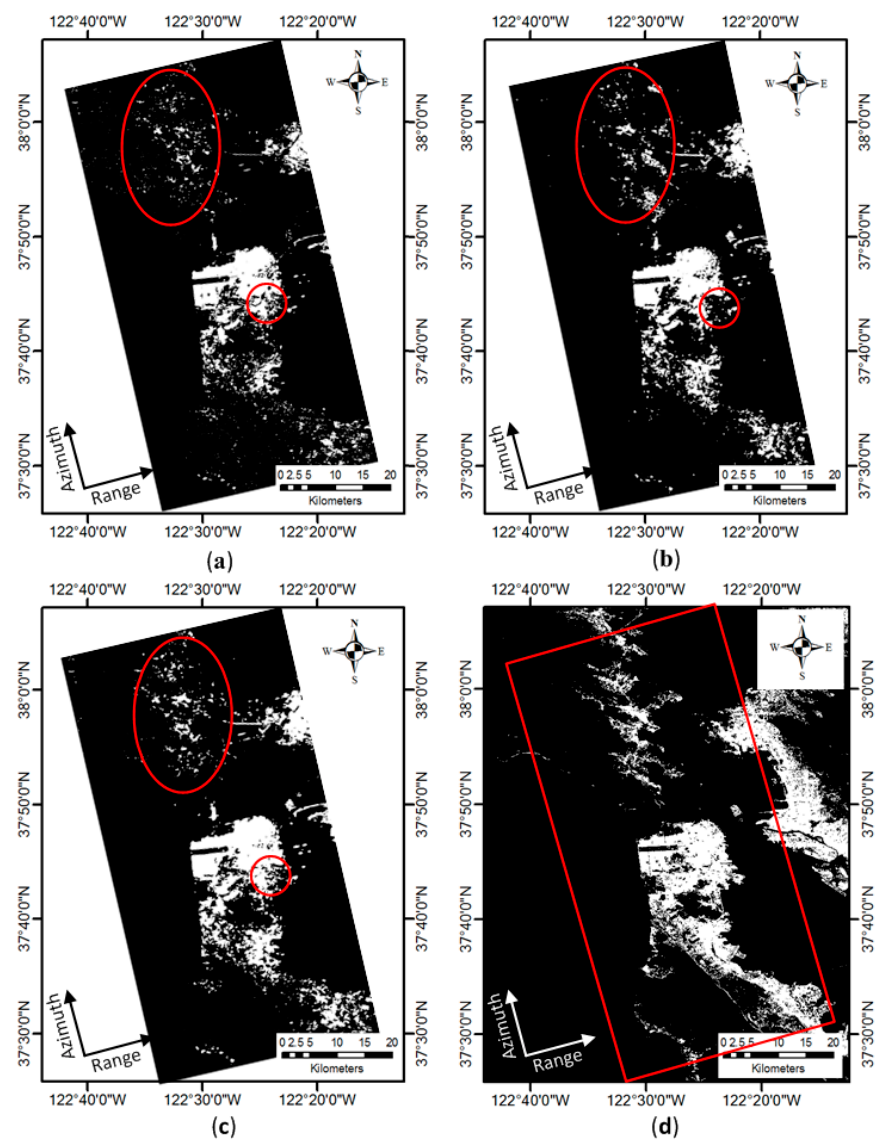
Figure 8. Built-up area extraction using the scattering powers, the average coherence coefficient ratio and the FCP fusion, where the white represents the building areas and the black areas are the non-buildings: ( a ) detection results using Condition 1 ; ( b ) detection results using Condition 2 ; ( c ) fused detection results; and ( d ) urban ground truth from NLCD 2006 land cover data, where the red rectangle represents the study area. Table 3. Comparison of the different detection results in Figure 8.